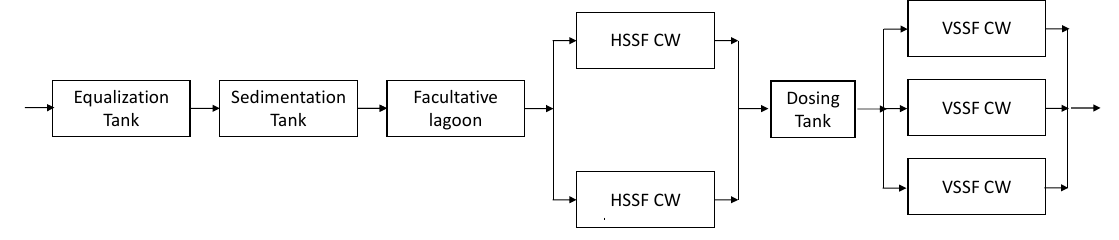
Figure 3. Diagram of the treatment train proposed for the zootechnical farm wastewater. Table 3. The main design parameters of the di ff erent treatment